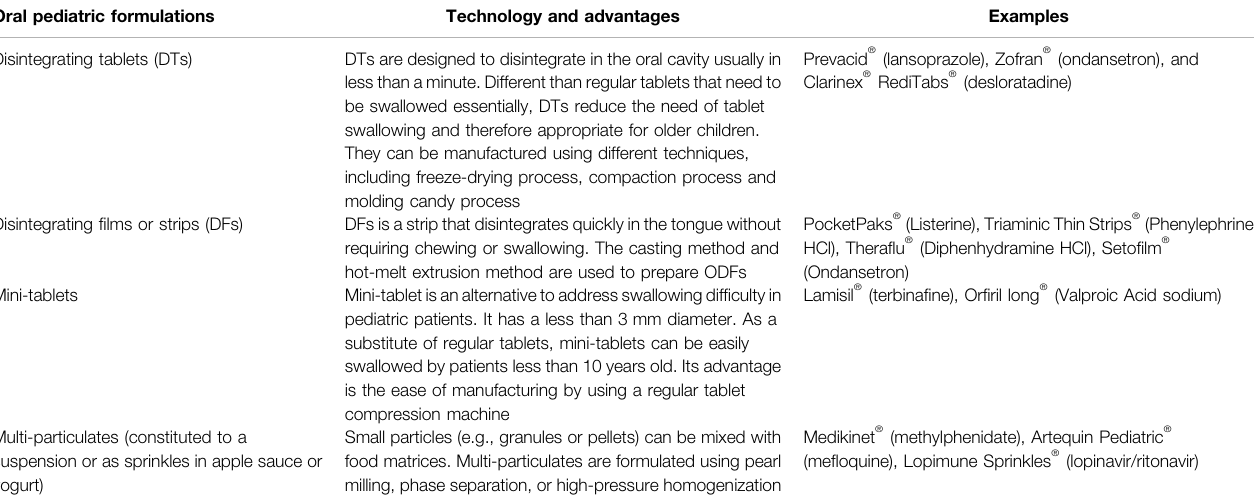
TABLE 11 | Representative list of marketed pediatric